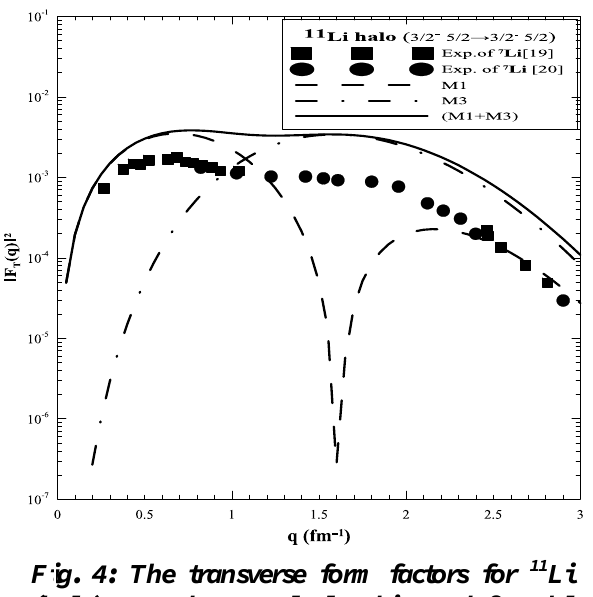
Fig. 4: The transverse form factors for 11 Li (halo) ground state calculated in spsdpf model space. The individual multipole contribution of M1 and M3 are shown. The data are the same as in Fig.